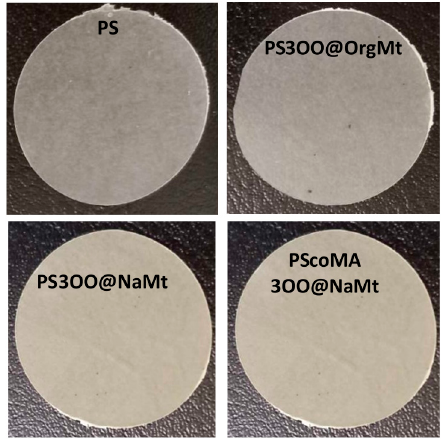
Figure 1. Representative photos of pure PS film and PS3OO@OrgMt, PS3OO@NaMt